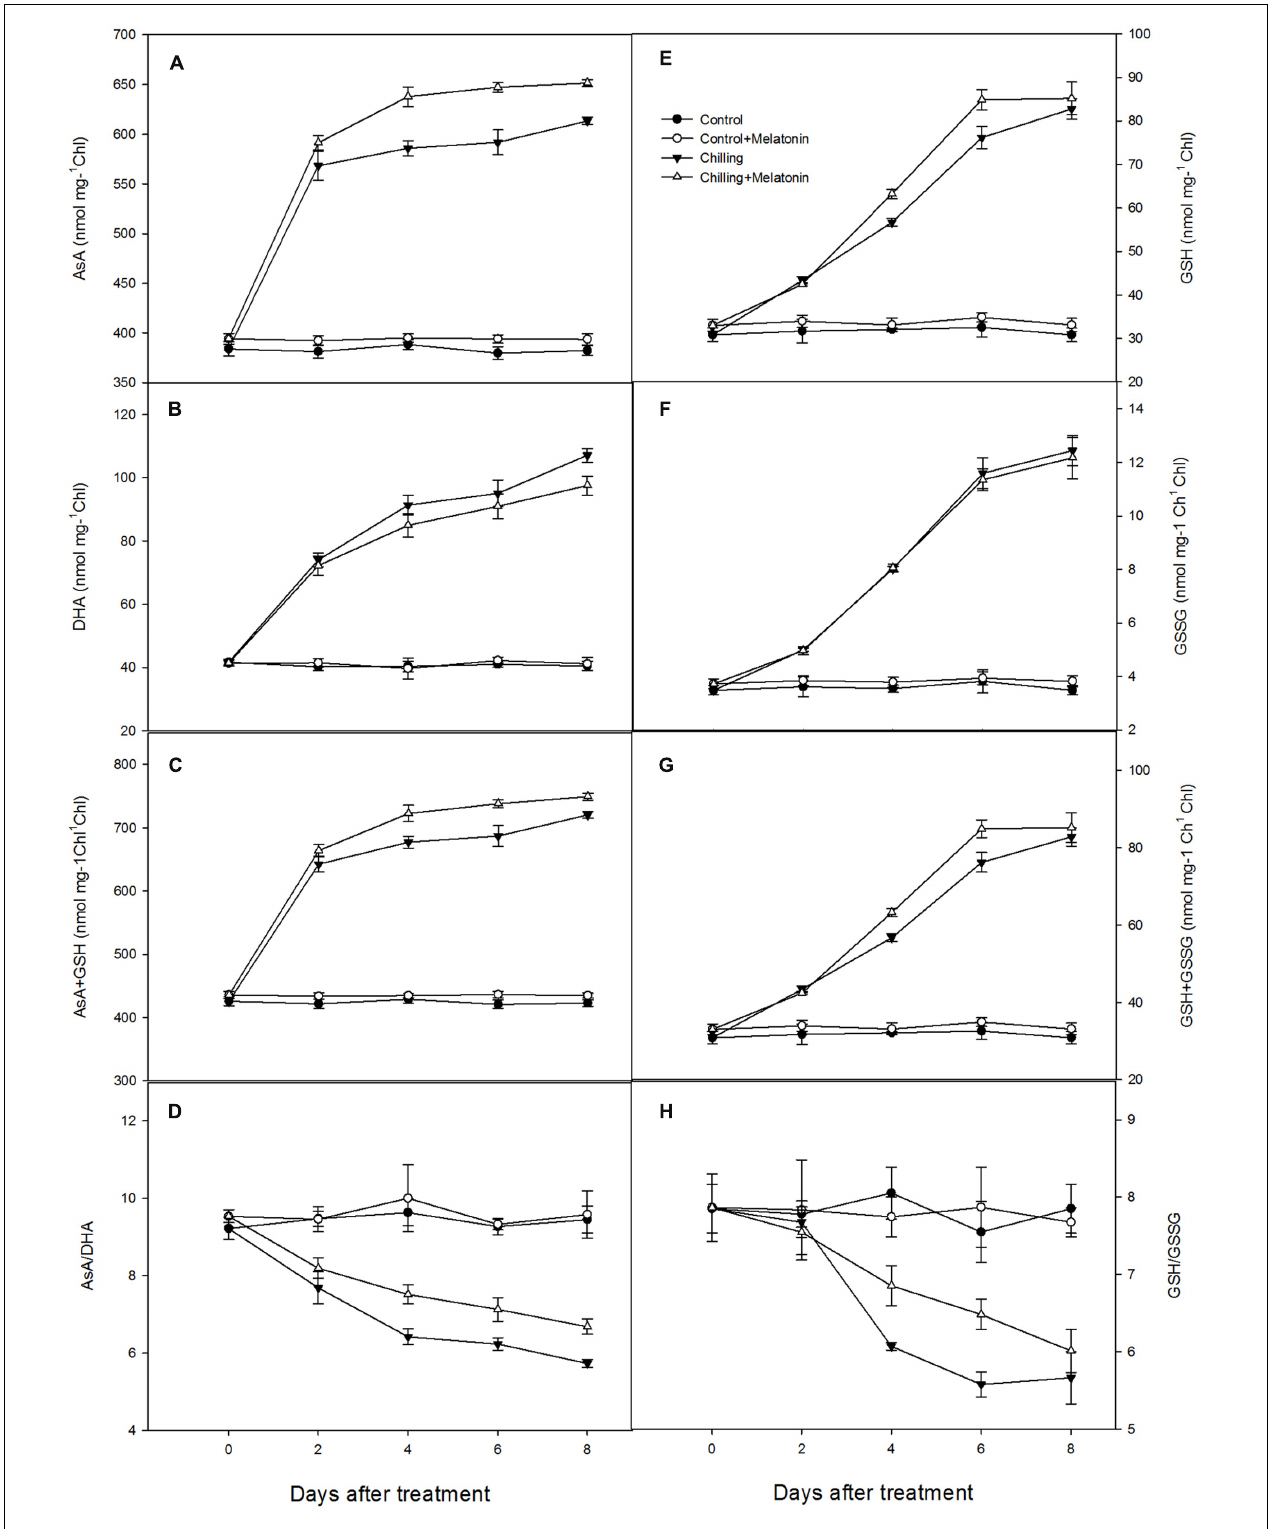
FIGURE 6 | Effects of exogenous melatonin on antioxidant content of chloroplasts under chilling stress: (A) ascorbic acid (AsA), (B) dehydroascorbate (DHA), (C) AsA + DHA, (D) AsA/DHA, (E) glutathione (GSH), (F) oxidized glutathione (GSSG), (G) GSH + GSSG, (H) GSH/GSSG. Control (28/18 ◦ C); Control + Melatonin (200 µ M melatonin, 28/18 ◦ C); Chilling (15/8 ◦ C); Chilling + Melatonin (200 µ M melatonin, 15/8 ◦ C). Data are means ± SD of three replicates.